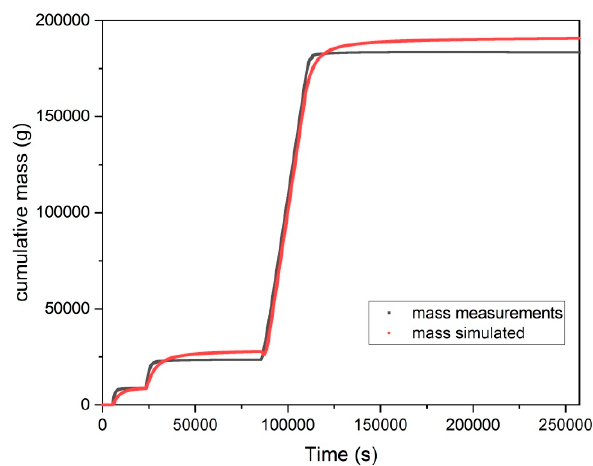
Figure 10. Evolution of the cumulative mass of water leaving the tank during the drainage and rainfall part of the 2nd experiment; the red line depicts the results of simulation and the black line represents the measurements.